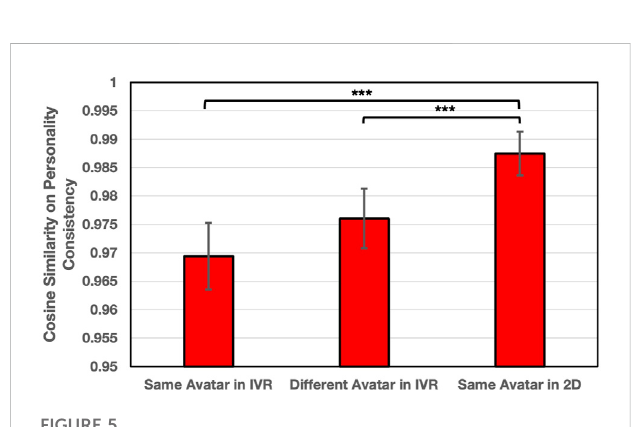
A Voice Transformer 4 effect processor device was utilized for voice quality conversion, to modify the pitch effect, which adjusts the height of the voice, and the formant effect, which adjusts the peak of the frequency. A Roland Rubix 24 was employed as the audio interface.